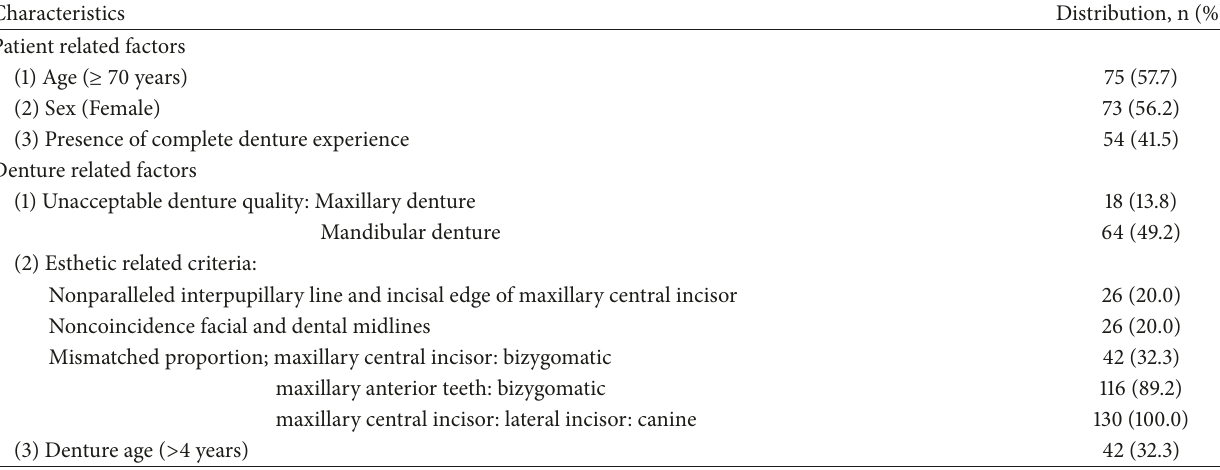
Table 1: Characteristics of the participants and their complete dentures (N =